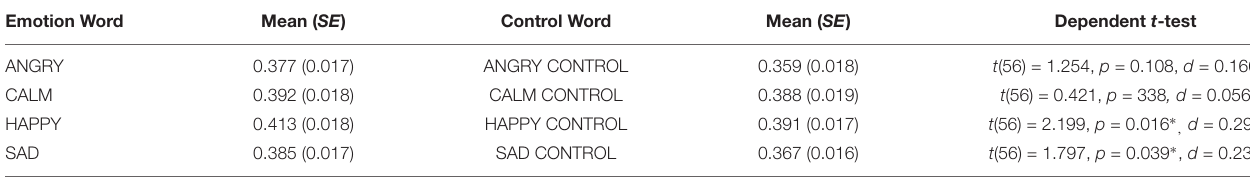
TABLE 3 | Predominance ratios with “No Response” key for each of the four emotion categories and respective controls for Experiment 1. Emotion Word Mean ( SE